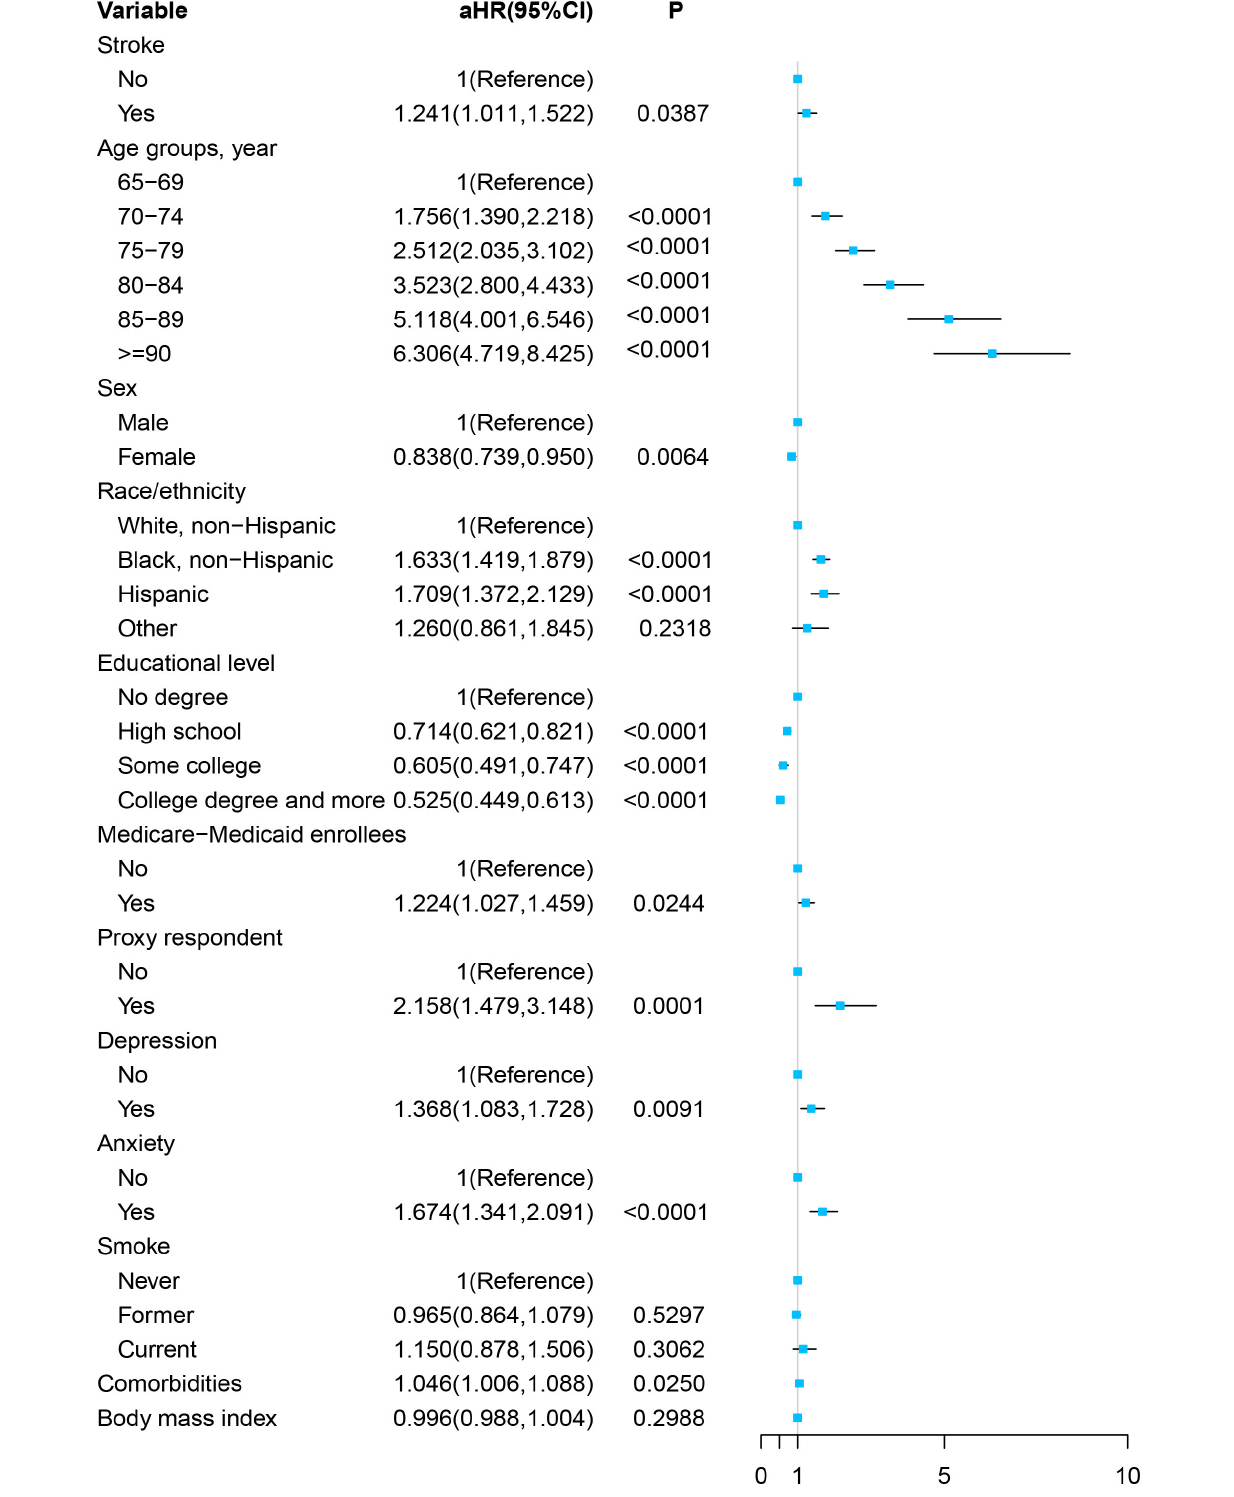
FIGURE 2 | Forest plot of multivariable proportional hazards regression modeling the development of cognitive impairment over 8 years of follow-up.